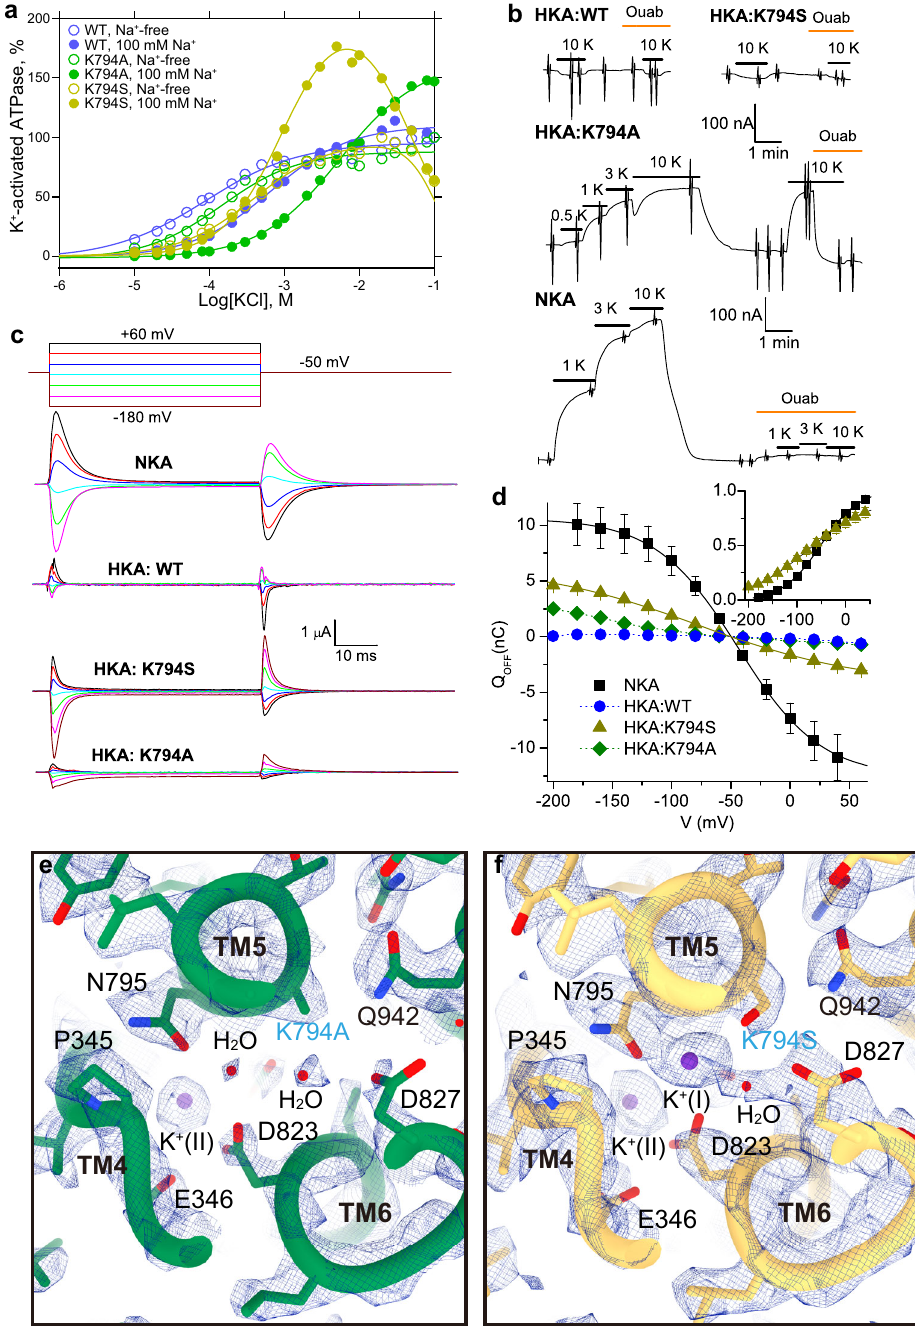
Fig. 3 | Functionaland structuralcharacterizationofWT-, K794S-, and K794A- top.Theprotocolwasrepeatedbeforeandaftertheapplicationofouabain(10mM ngHKA. a Representative results from more than three independent measure- forNKA,25mMforngHKAmutants)toobtainthepump-speci fi csignalsdisplayed mentsofK + -dependentATPaseincrudemembranefractionsfromcellsexpressing (current without ouabain minus current in ouabain). d Mean Q – V from experi- ngHKA WT (blue), K794A (green) and K794S (yellow), measured in the absence ments like those in ( c ). The Boltzmann fi tted to individual experiments had (open symbols) or in the presence ( fi lled symbols) of 100mM Na + . The maximum V 1/2 = − 75± 2mV and kT/z q e =64±3mV ( n =16) for Lys794Ser (yellow line), and K + -activated activity without Na + was set as 100% and that without K + or Na + , as V 1/2 = − 51± 1mV and kT/z q e =40±1 ( n =12)forNKA.Data for Lys794Ala( n =7) and blank.LineplotsareHill fi ts(see “ Methods ” ). b Currentat − 50mVfromNa + -loaded WT ( n =4) could not be fi tted. e Ion-binding sites of K794A-ngHKA with a K + ion oocytesexpressingWT-,K794A-,andK794S-ngHKAorNKApumps.Applicationof modeled at site II. Water was modeled in the weak density near site I (side-chain K + activated outward currents only in oocytes expressing K794A-ngHKA oxygensofAsn795(2.30Å)andAsp823(2.39Å)aretooclosetoaccommodateK + ). f Ion-binding sites of K794S-ngHKA. Strong densities are consistent with K + ions (K 0.5 =2.8±0.7mM, nH =1.75, n = 5) or NKA (K 0.5 =1.21±0.34mM, nH =1.47, n =9). Note similar K bound at both sites. Both K + -occluded structures are viewed from the 0.5 for current and ATPase activation at 100mM Na + for Lys794Ala.Ouabain(25mMngHKA&10mMNKA)blockssubsequentresponsesto cytoplasmic K + . c Ouabain-sensitive transient currents elicited by the pulse protocol shown on